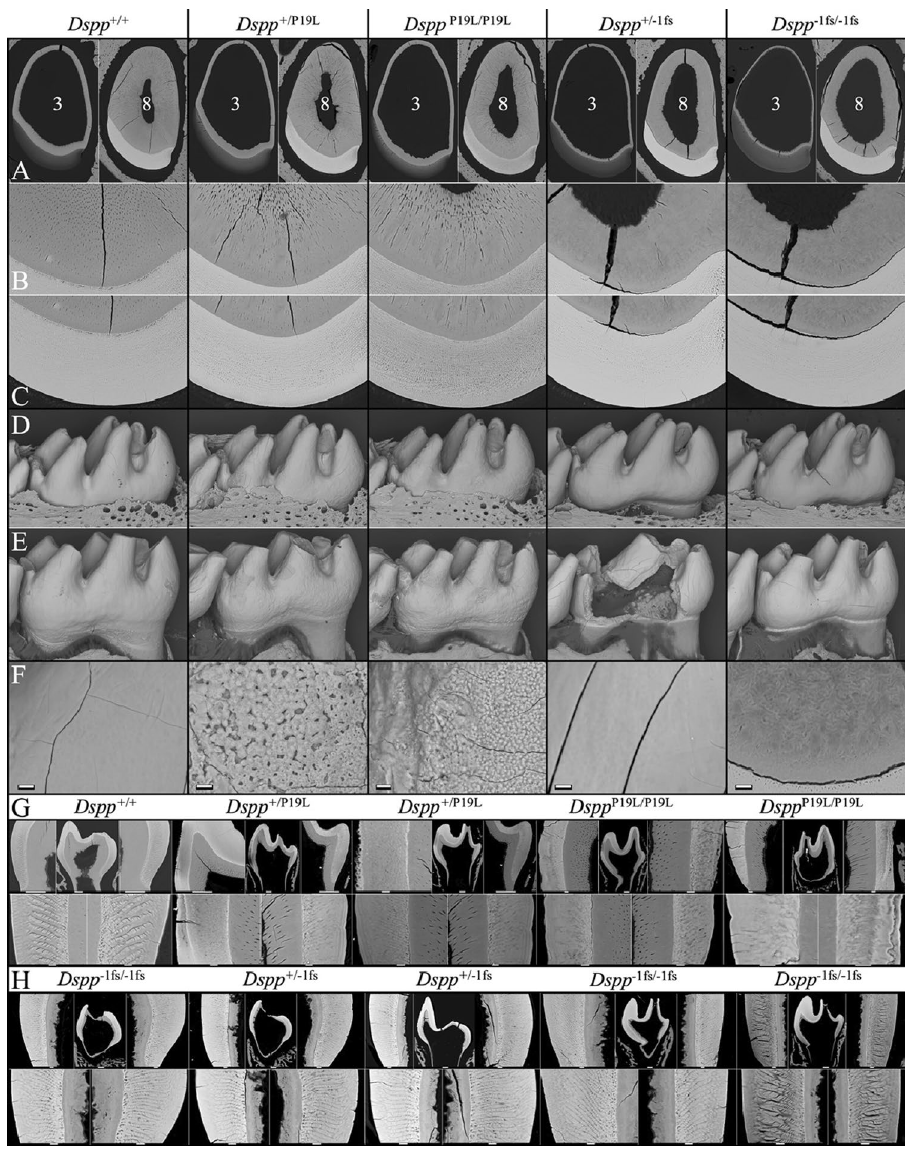
Figure 2. bSEM imaging of tooth defects in Dspp + / P19L , Dspp P19L / P19L , Dspp + / −1fs , and Dspp −1fs / −1fs Mice. ( A ) 7-week-old incisor cross-section (75×) from level 3 (left) and level 8 (right). Enamel is of normal thickness and contour in all genotypes. The dentin layer (pulp to DEJ) is somewhat thinner in Dspp P19L , and thinner in Dspp −1fs incisors relative to the WT. ( B ) Level 8 images (400×) of dentin show complete absence of dentinal tubules in Dspp −1fs mouse incisors. ( C ) Level 8 images (400×) of enamel show normal thickness and rod patterns, although the rod patterns stand out more in the Dspp P19L mice, suggesting hypomineralization. ( D ) Erupting D14 mandibular first molars (70×) show normal shape and contour, although the Dspp P19L distal-buccal cusps appear thinner and exhibit enamel surface roughness. ( E ) At 7 weeks, the erupted Dspp P19L molars show enamel surface roughness and accelerated attrition, whereas the Dspp −1fs molars show normal surface texture, accelerated attrition, and sometimes crown failures. ( F ) 7-week (1000×; bar = 10 µm) molar surface images showing poorly mineralized enamel surface in Dspp P19L molars, normal enamel surface in the Dspp +/−1fs molar. Also shown is a higher magnification (1000×) view of irregular growth lines roughly parallel to the DEJ in Dspp −1fs / −1fs incisor dentin at level 8, which is also typical of Dspp +/−1fs dentin (not shown). ( G,H ) bSEM images of D14 molar cross- sections. Scale bars: molar cross-sections, 100 µm; all others, 10 µm. The Dspp P19L molar enamel is unevenly mineralized and lacks the clearly defined rod/interrod structures of wild-type enamel, while the dentin contains well-defined tubular structures. ( H ) bSEM images of D14 molar cross-sections. The Dspp −1fs mouse molar enamel show clearly defined rod/interrod structures, while the dentin is extremely thin and lacks dentinal